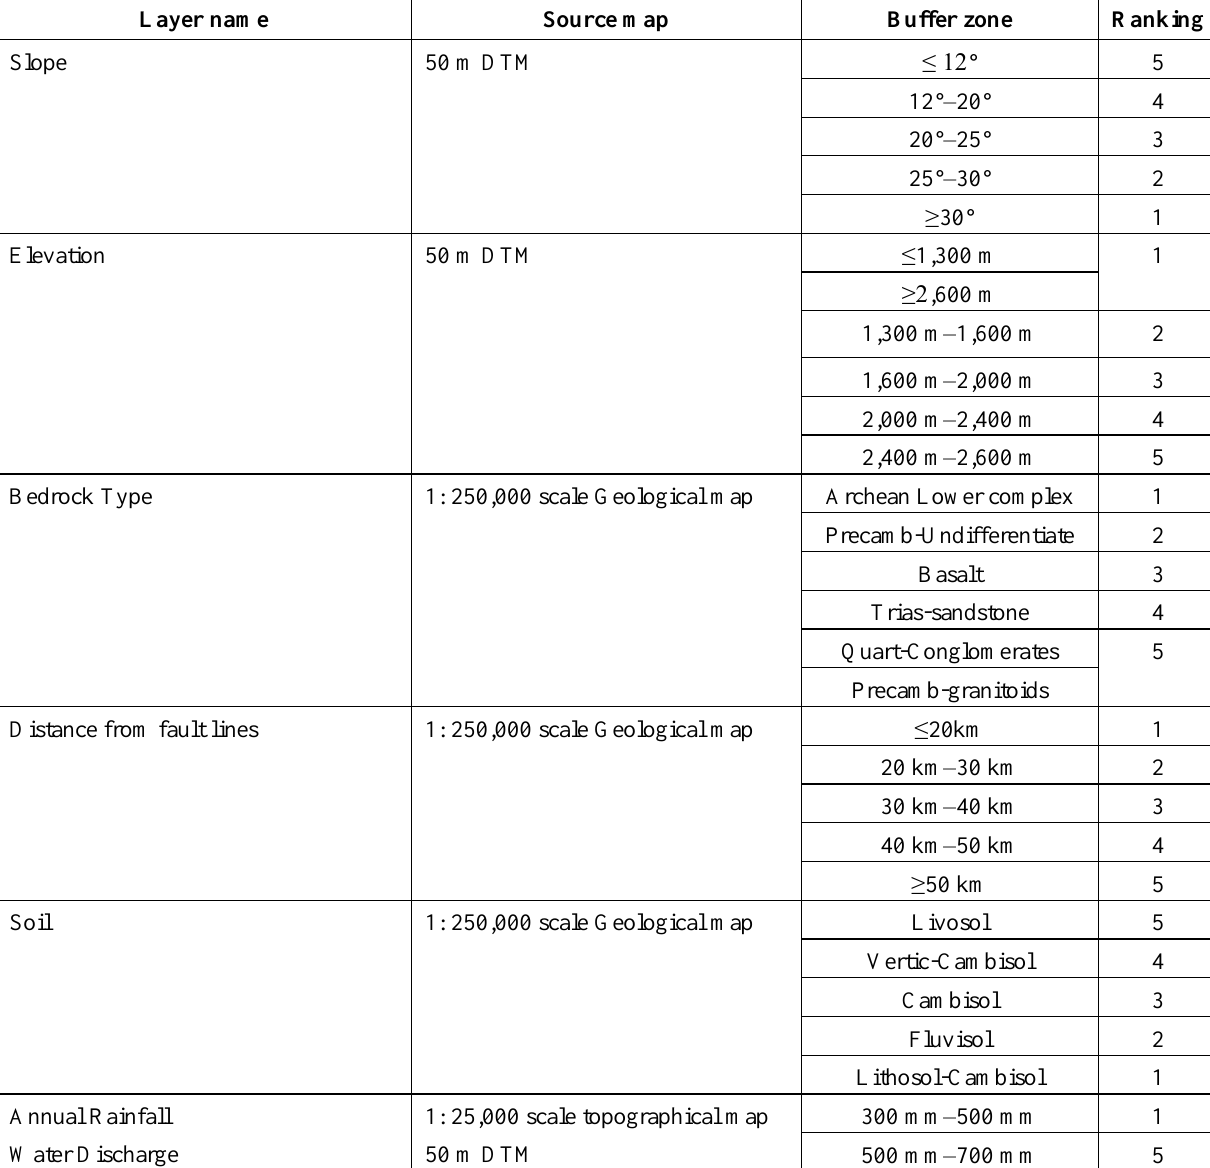
Table 1. Summary of the input layers used in this